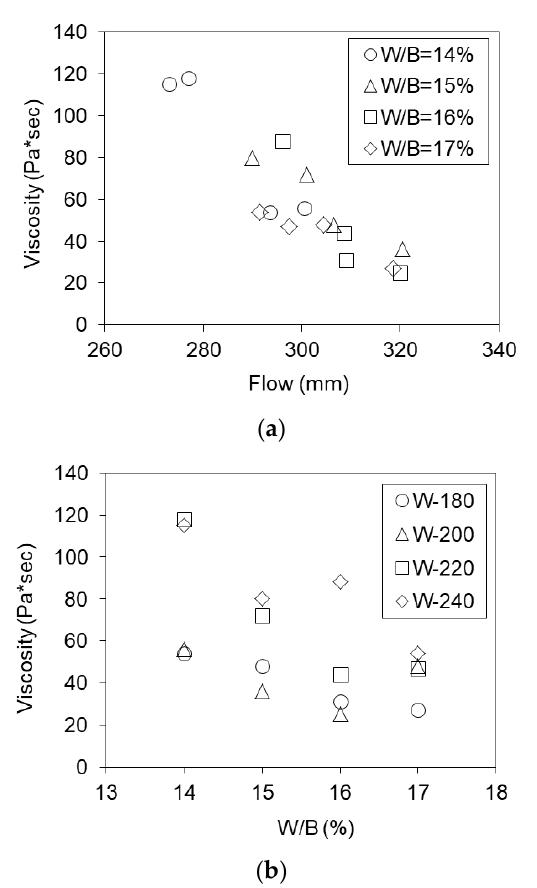
Figure 11. Mortar viscosity. ( a ) Mortar flow — viscosity. ( b ) W/B — viscosity.